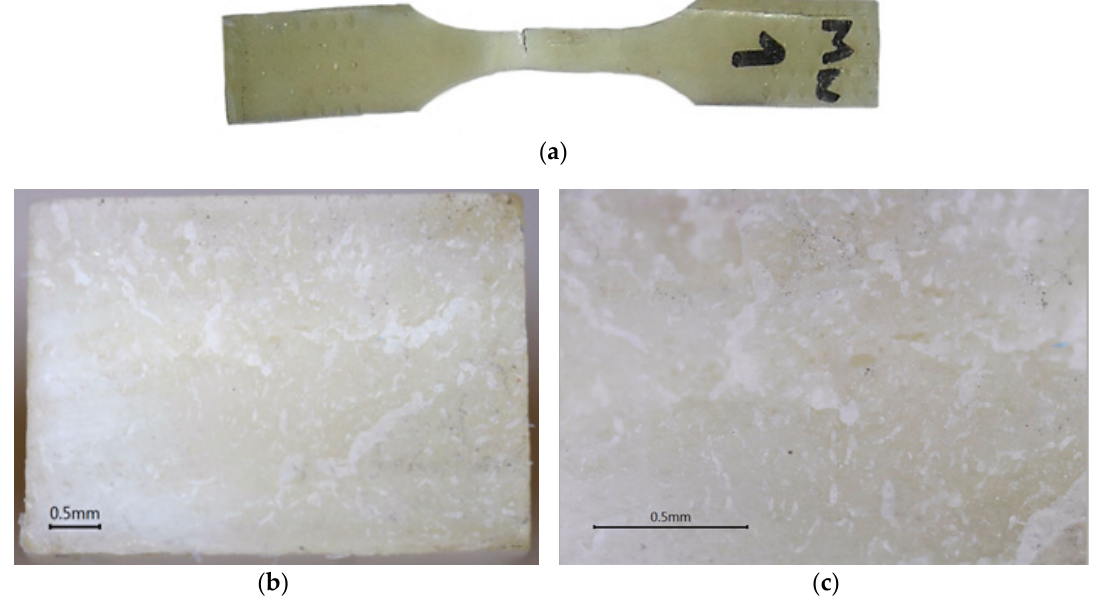
Figure 15. An example of specimen damage during tension: ( a ) view of the whole specimen, ( b ) view of the whole fracture, ( c ) zoom of the fracture fragment.